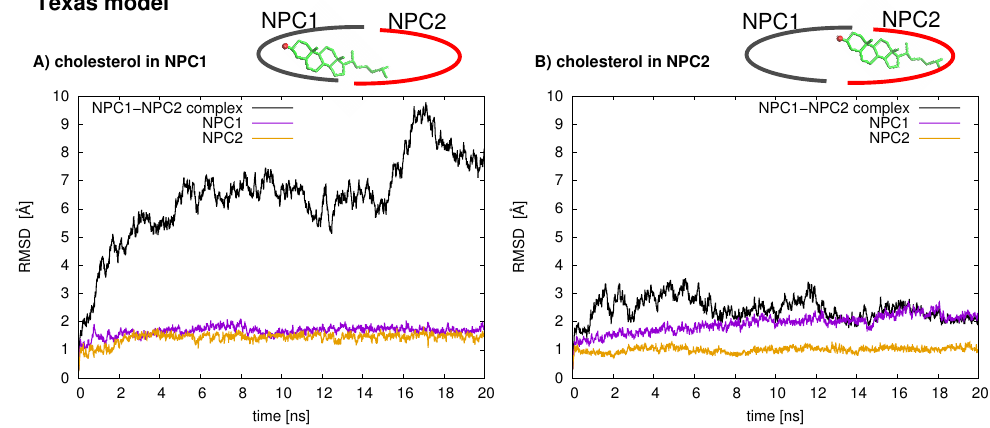
Figure 2. Protein backbone atom RMSD values for the NPC1(NTD)–NPC2 complex of the Texas model based on the structure proposed in Ref. [3,6] is shown: ( A ) with cholesterol in the NPC1 binding pocket; and ( B ) with cholesterol in the NPC2 binding pocket. Black line corresponds to the RMSD for the total protein–protein complex, purple line corresponds to RMSD of NPC1 protein, and orange line corresponds to RMSD of NPC2 protein.